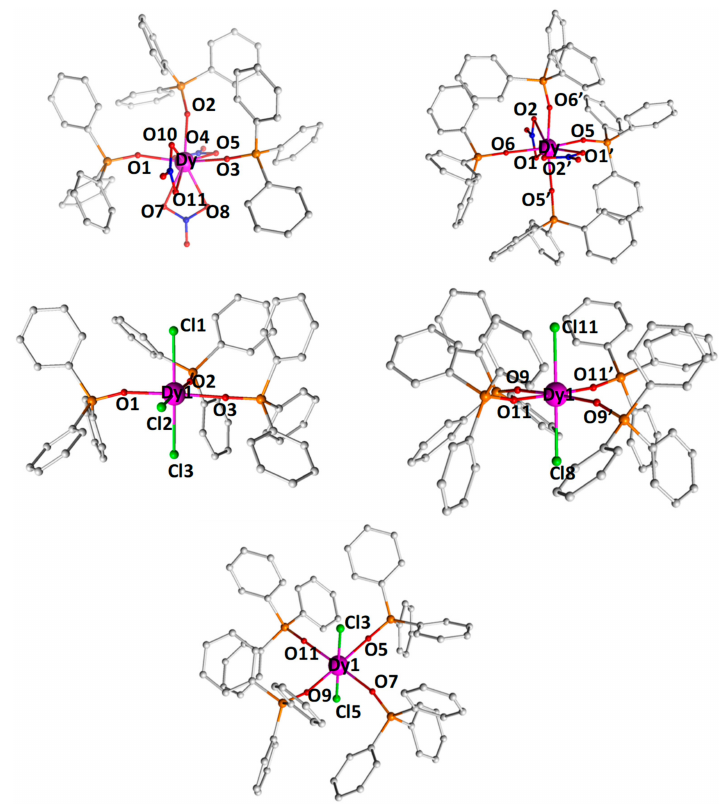
Figure 1. Molecular structure of 1 ( top left ), 2 ( top right ), 3 ( middle left ), 4 ( middle right ) and 5 ( bottom ). The H-atoms and counterions are omitted for clarity. Colour scheme: Dy III , purple; P, orange; Cl, green; O, red; N, blue; C, light